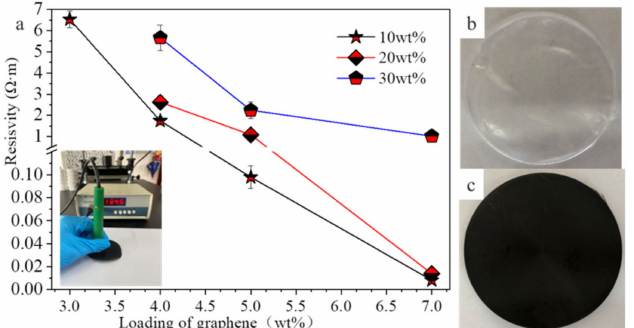
Figure 1. ( a ) Resistivity of the composite films prepared with different loadings of graphene, TPU initial concentrations and photographs of pure TPU film ( b ) and G-TPU film ( c ). The insert is a photograph of testing